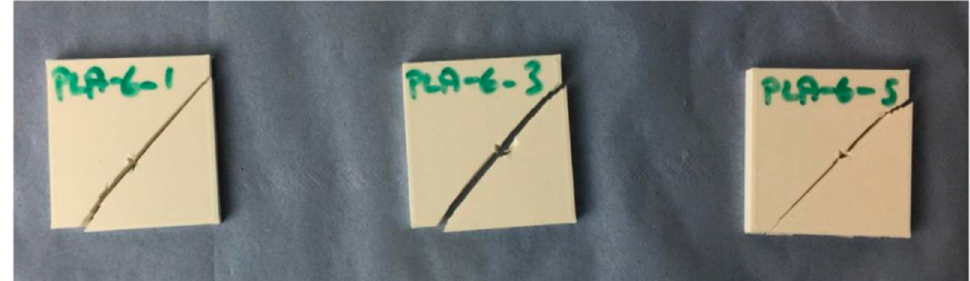
Figure 5. Fractured PLA specimens after stab test. Reprinted from [45], originally published under a CC-BY-NC